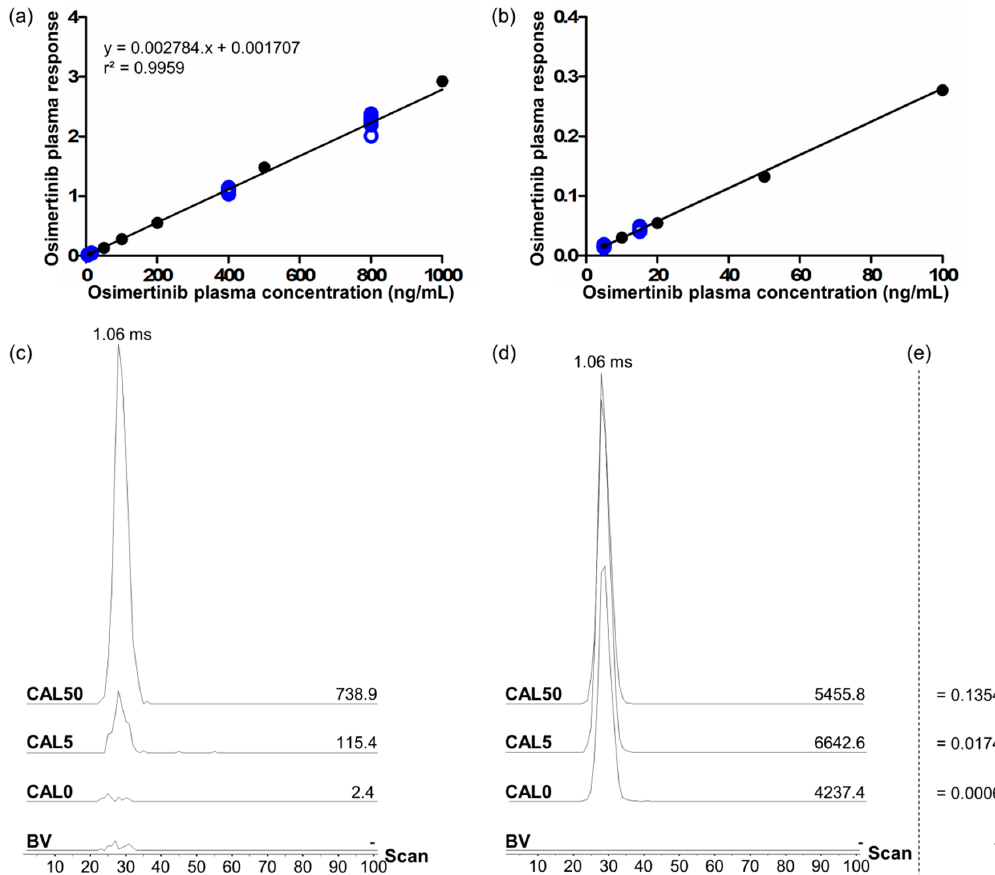
Figure 4. Calibration curve obtained for one of the validation batches ( a ) from 5 to 1000 ng / mL and ( b ) on a zoomed range from 5 to 100 ng / mL showing the mean responses (arbitrary units) obtained for the di ff erent calibration levels (full black circles, standard deviations are displayed but too low to be visible on the graphs) and the responses obtained for each individual quality control (QC) replicate (empty blue circles). Extracted ion mobilograms of ( c ) osimertinib (mass / charge ( m / z ) range: 185.094 to 185.121) and ( d ) [ 13 C, 2 H 3 ]-osimertinib ( m / z range: 189.125 to 189.140) for a blind value sample (BV), a CAL0 sample (BV with internal standard), a CAL5 sample (LLOQ level), and a CAL50 sample (50 ng / mL osimertinib). On the right of each baseline the peak area in arbitrary units is given; the computed responses corresponding to each sample are given in ( e ).